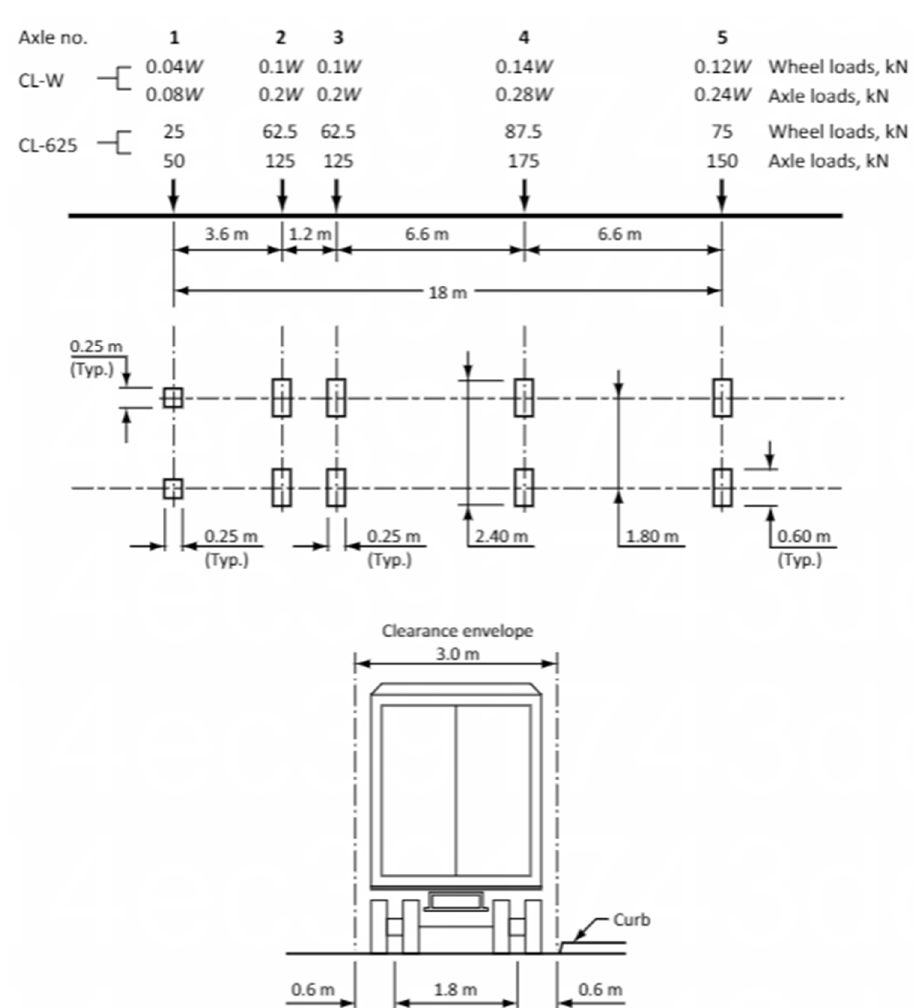
Figure 5. The CHDBDC loading truck CL-625 arrangement.